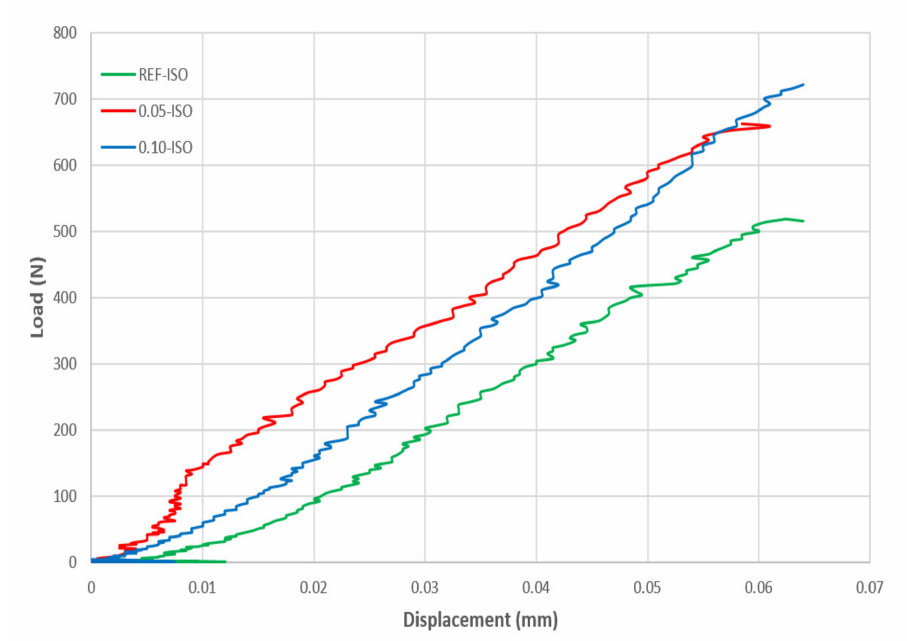
Figure 9. Three-point flexural test load-displacement diagrams.